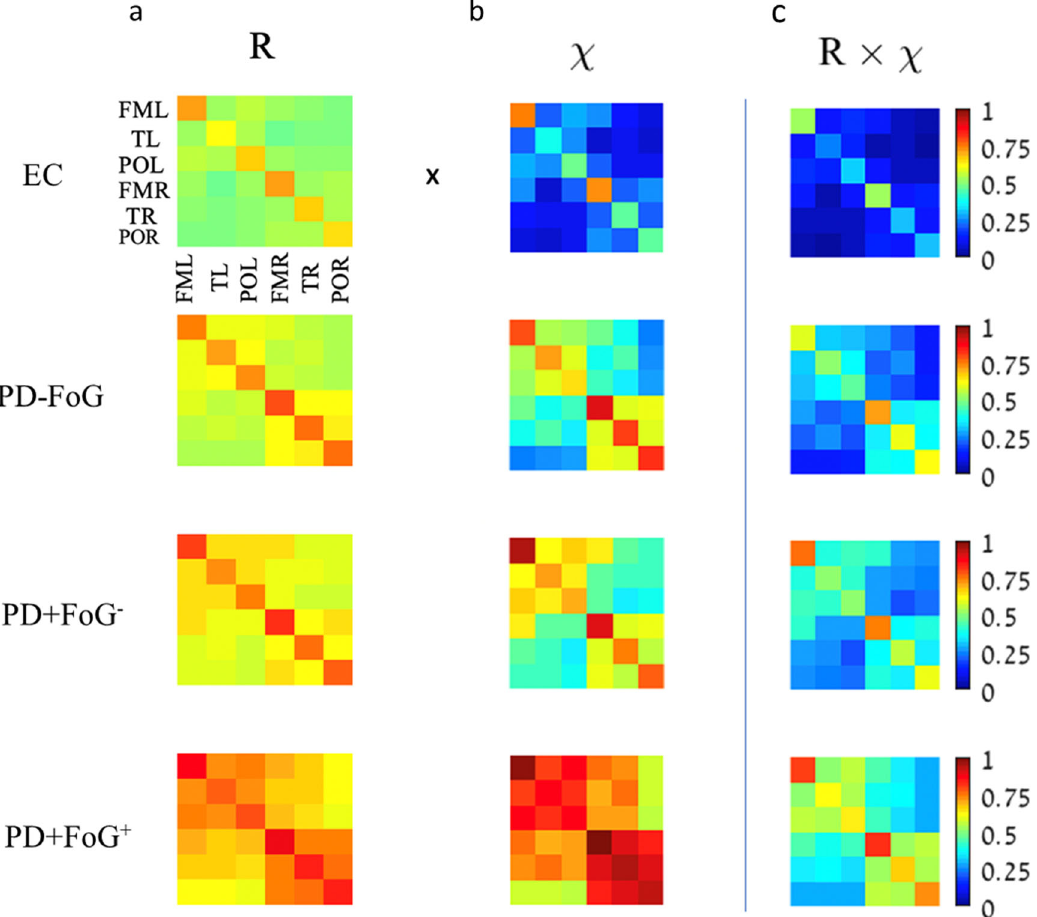
Fig. 2 Brain lobe interaction matrix calculated from synchronization and fraction matrix. Element-wise multiplication of a synchronization matrix R and b fraction matrix χ yields c the total brain lobe interaction matrix R × χ that is used as the adjacency matrix of the underlying physiological network of brain lobe interactions (Fig. 3). In this fi gure, all matrices are derived for α − α interactions during normal walking epochs. Group average matrices for EC, PD-FoG, PD + FoG − and PD + FoG + (from top to bottom) are shown. Note, there is a dramatic increase in brain lobe interaction with the severity of Parkinson ’ s disease which is represented by (i) higher levels of α − α synchronization, as well as (ii) higher fractions of signi fi cant interactions.